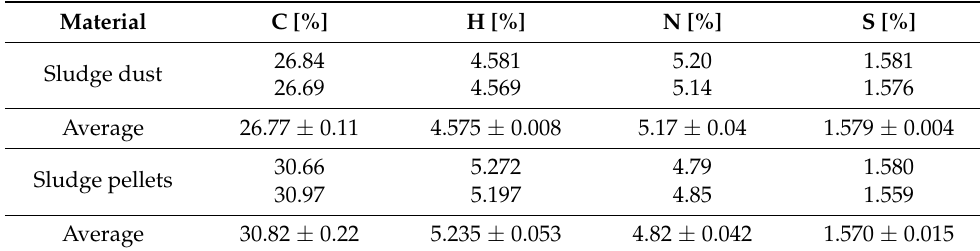
Table 3. The elemental analysis